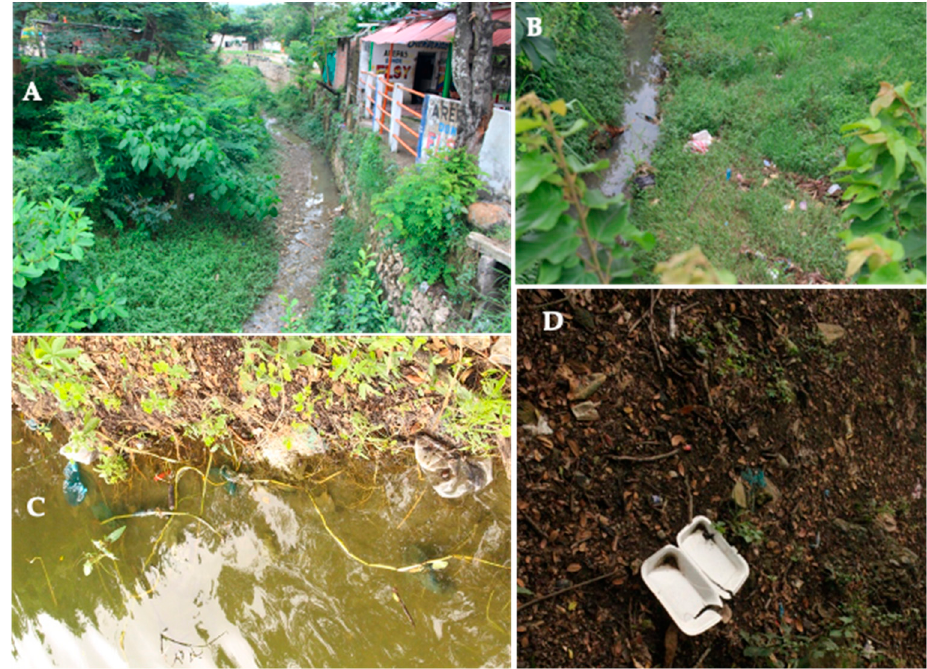
Figure 7. Inappropriate disposal of plastic waste in Luruaco Lake. ( A , B ): Limón stream bank. ( C , D ):